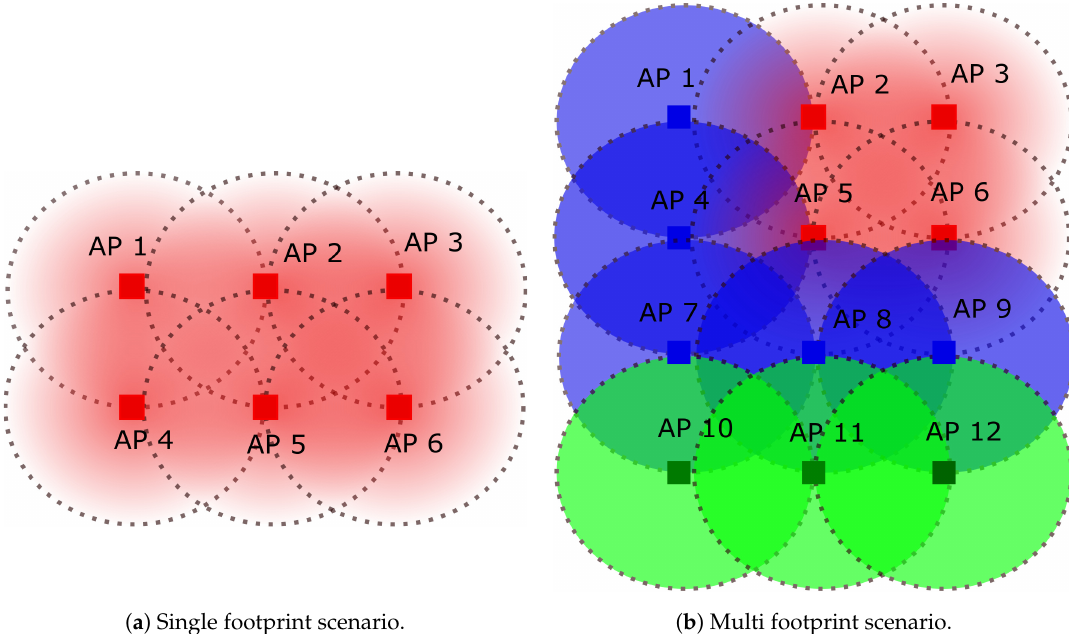
Figure 12. Types of footprint scenarios. Dashed circumferences represent coverage areas rather than illumination